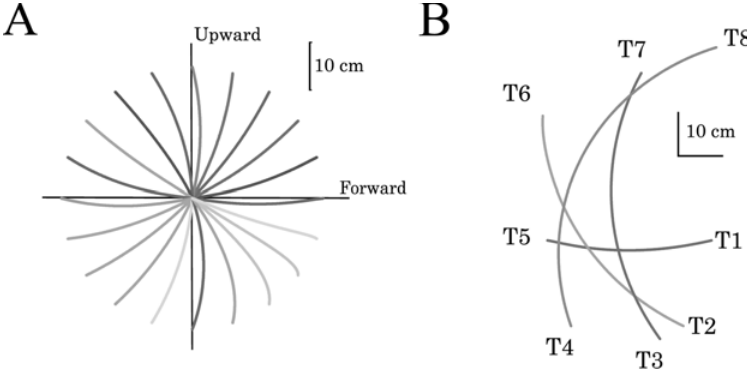
Figure 7. Simulated fingertip paths in the 2-dof case. (A) Finger trajectories for different movements toward targets located on a circle. Initially the finger position is at the center of the circle. For more details about the task and to compare the results, see [33,52]. (B) Finger trajectories for four different movements performed in the sagittal plane (T1 to T5, T2 to T6, T3 to T7, and T4 to T8). For more details about the task and to compare the results, see